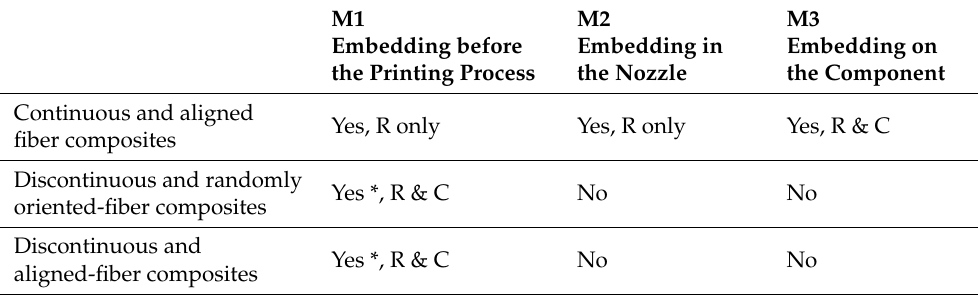
Table 5. Matrix of fiber embedding method and type of fiber length, C—commercially available; R—under research; * Orientation of fibers depends on nozzle